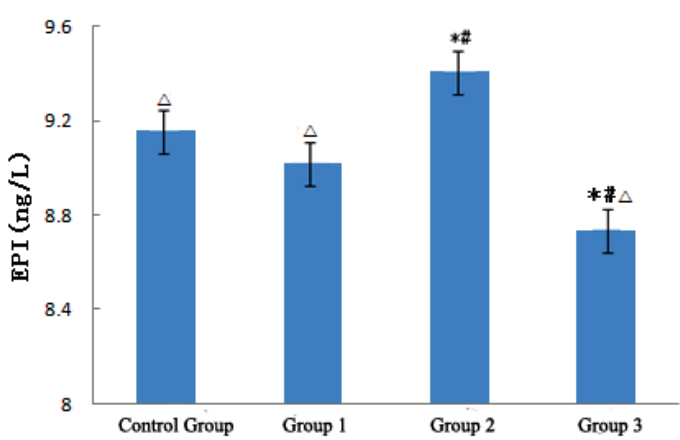
Figure 4. Analysis of EPI in ApoE − / − mice. Compared with the control group, * p < 0.01; Compared with the heat wave group, # p < 0.01; Compared with the temperature drop group, △ p < 0.01.